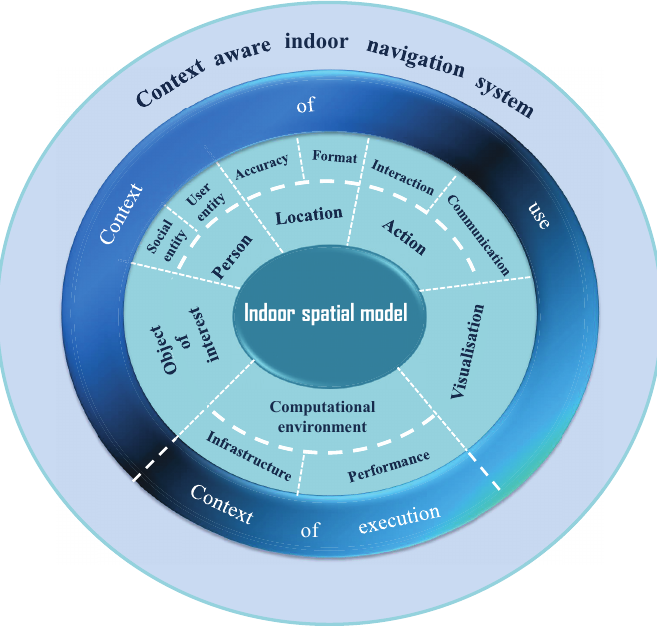
Figure 2: Indoor spatial model to context-aware indoor